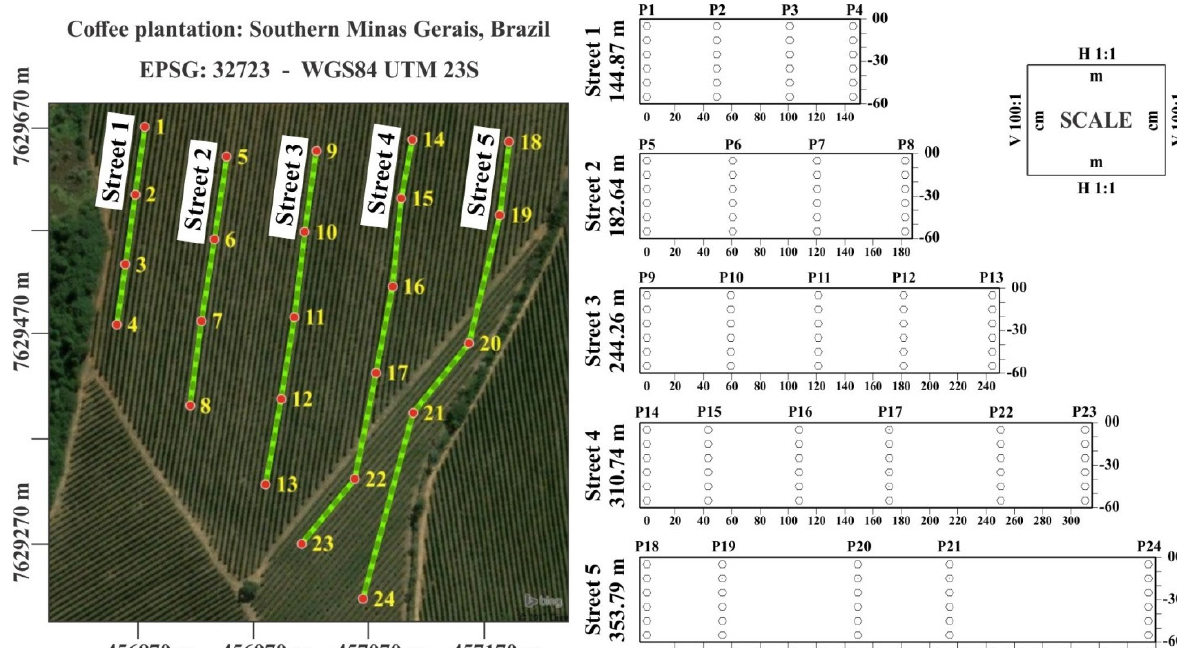
Figure 1. Definition of the study area with a distribution of sampling points by coffee streets, configuring respective longitudinal profiles and sampling points at a maximum depth of 0.60